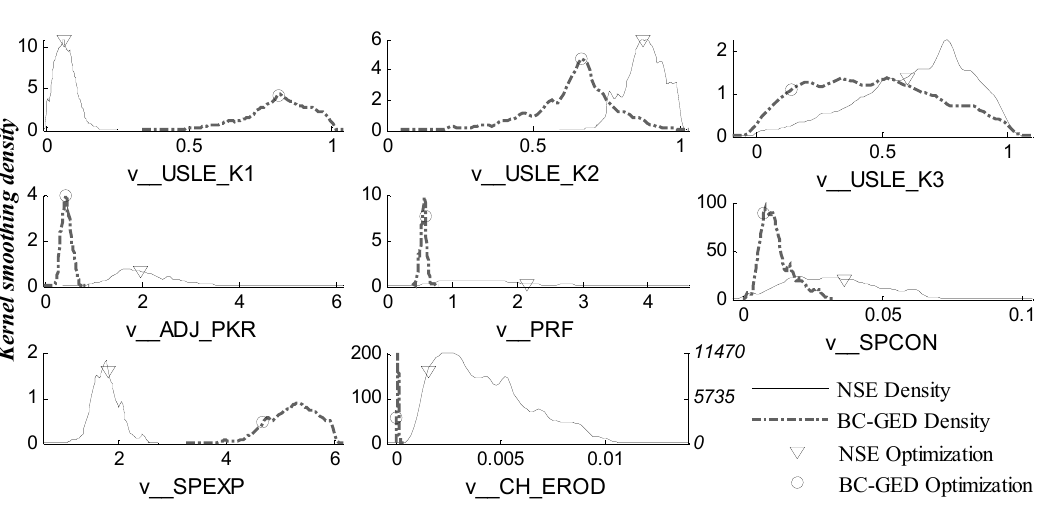
Figure 6. Comparison of the posterior distribution and optimal value (point) of sediment parameters estimated by the multi-objective NSE and BC-GED approaches.